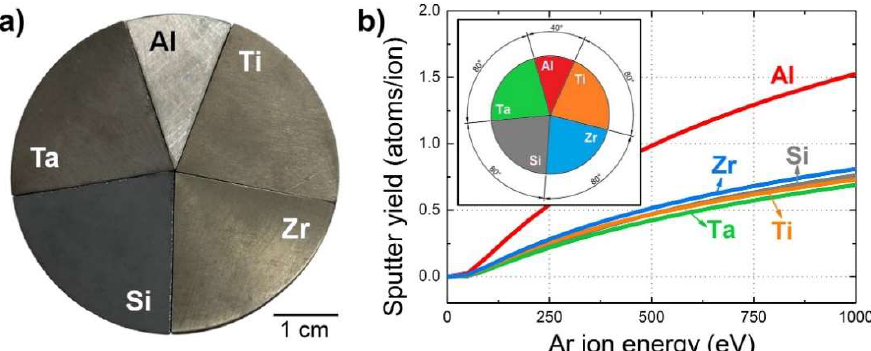
Figure 3. ( a ) Photograph of the AlSiTaTiZr multi-component “pizza-shaped” target used for the radio-frequency MS process, and ( b ) sputter yield for Ar + ions at different energies impinging on the five elements present in the target. Reproduced with permission from [24]. Copyright 2020, Else- vier.